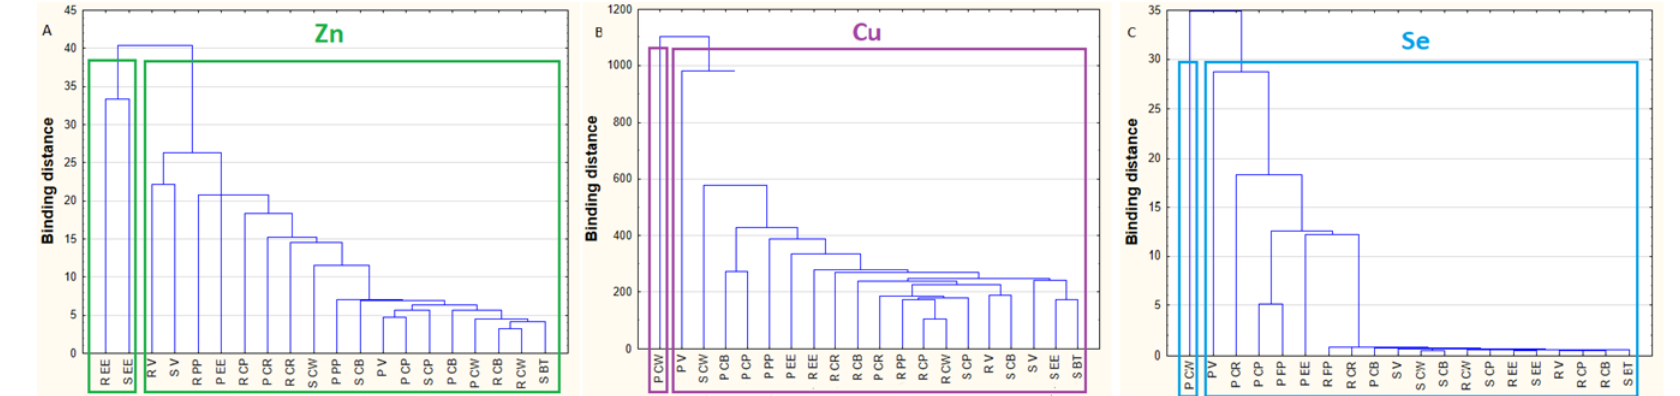
Figure 4. Cluster analysis of raw, smoked and pickled freshwater fish in terms of their Zn content ( A ), Cu content ( B ) and Se content ( C ). P CB — pickled common